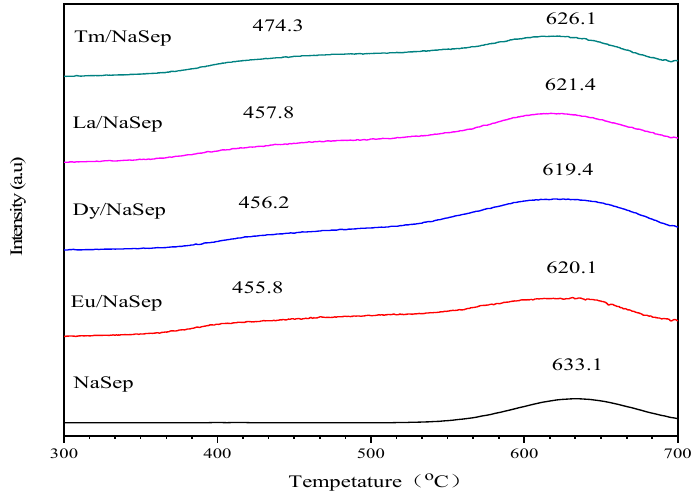
Figure 6. H 2 –TPR profiles of the samples.